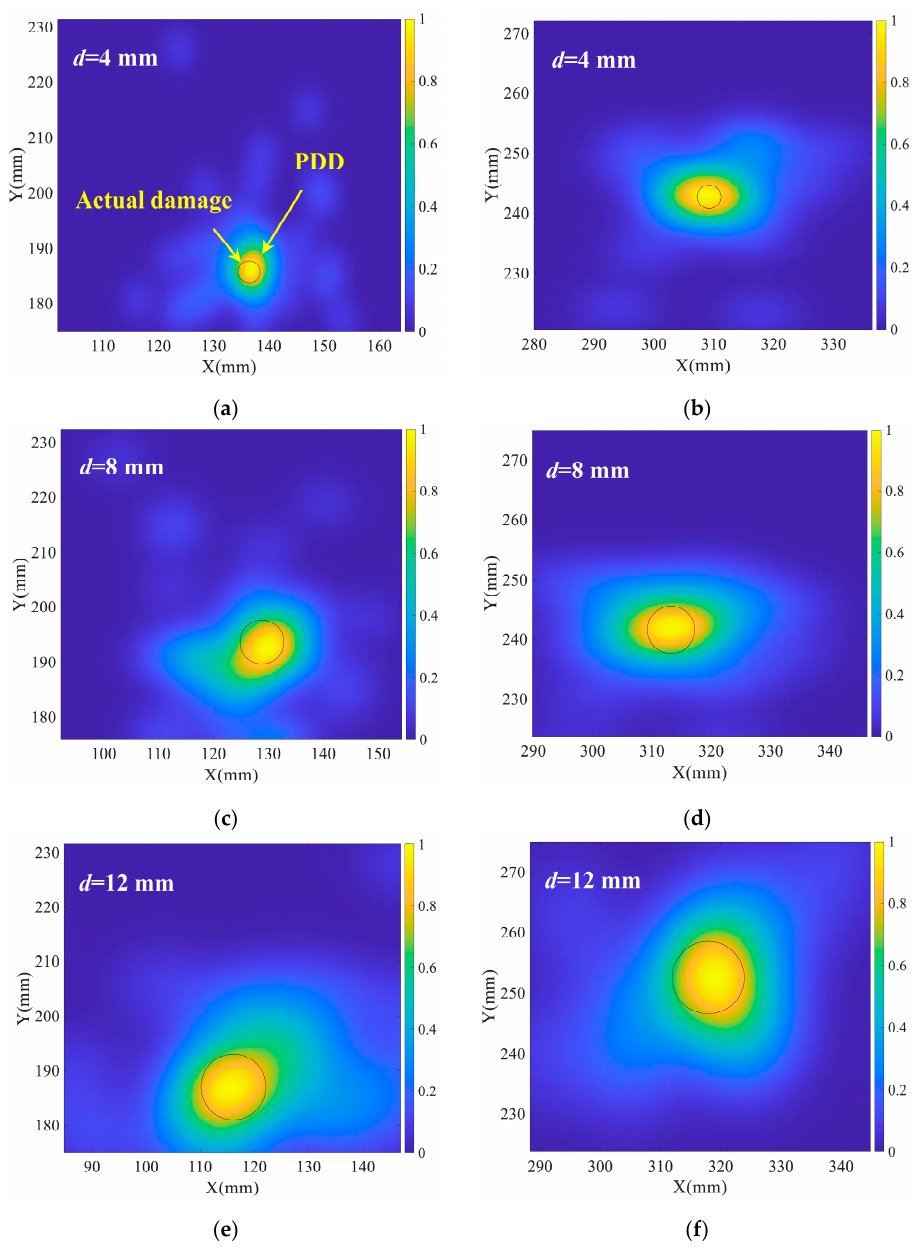
tion. Figure 12a,c,e shows the quantification results of damage with the center position (127 mm, 185 mm) and Figure 12b,d,f shows the quantification results of damage with the center position (320 mm, 245 mm). Meanwhile, the normalized Gaussian kernel proba- bility density distribution results were presented in Figure 12, and the black circle rep- resents the actual damage size in the predicted damage center.